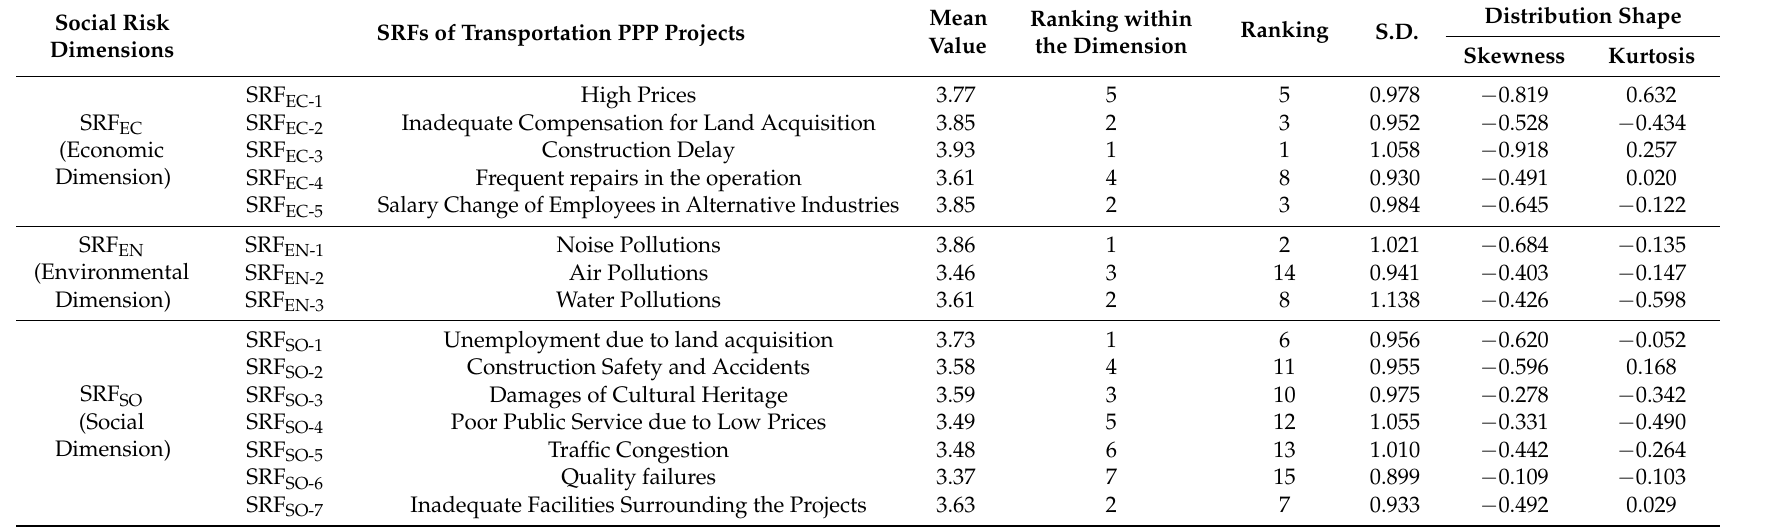
Table 4. The mean values and rankings for transportation PPP projects in